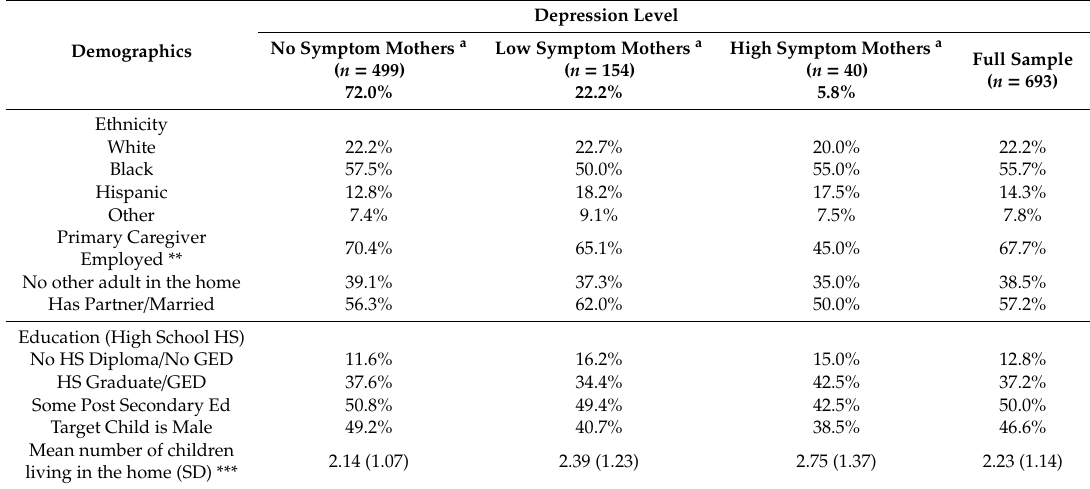
Table 2. Demographic characteristics by maternal depression level ( N =